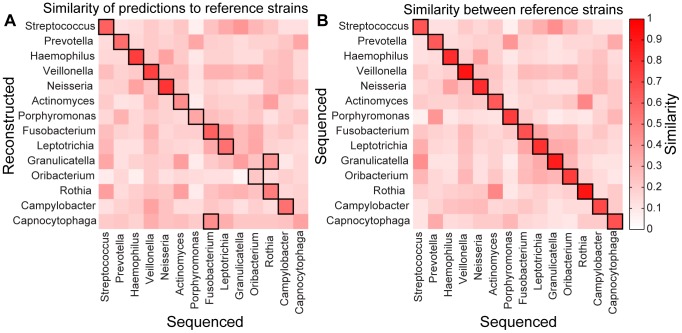
Reconstructing the genomic content of genera from HMP tongue dorsum samples.(A) The average similarity in KO content between each reconstructed genus and sequenced genomes from the various genera. Similarity is measured by the Jaccard similarity coefficient, over the set of the 500 KO with the highest variation across samples. Genera are ordered by their mean abundance in the set of samples under study. Entries highlighted with a black border represent the highest similarity in each row. (B) The average similarity between sequenced genomes from the various genera. Similarity was measured as in panel A.